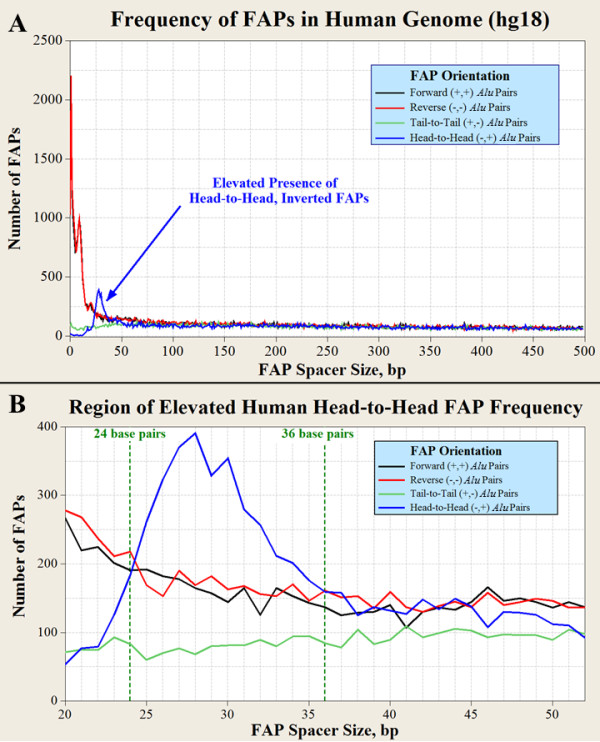
Frequency of closely spaced FAPs. (A) Human adjacent FAP frequency versus the spacer size (bp) separating the two members of the FAP. The number of inverted pairs (blue and green lines) is much lower than the number of direct pairs (red and black lines) when the spacer has a size ≤ 24 bp (I:D = 0.076); (B) Spacer lengths within 24 to 36 bp define the only region within the human genome where head-to-head (inverted) FAPs outnumber either type of direct oriented FAPs. Bp: base pair; FAP: full-length Alu pair.